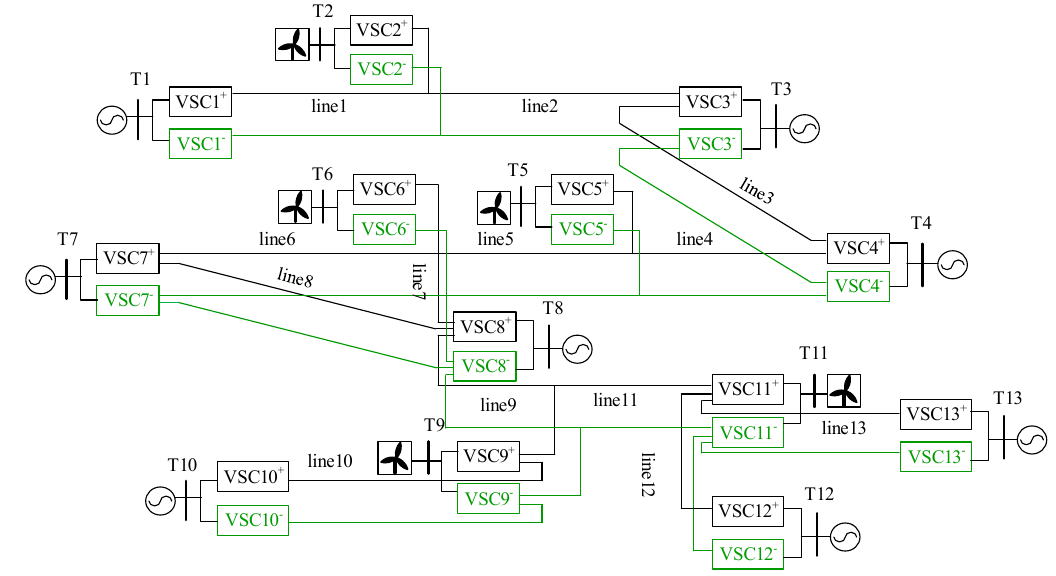
Figure 11. The topology of the larger scaled bipolar VSC-MTDC benchmark system.